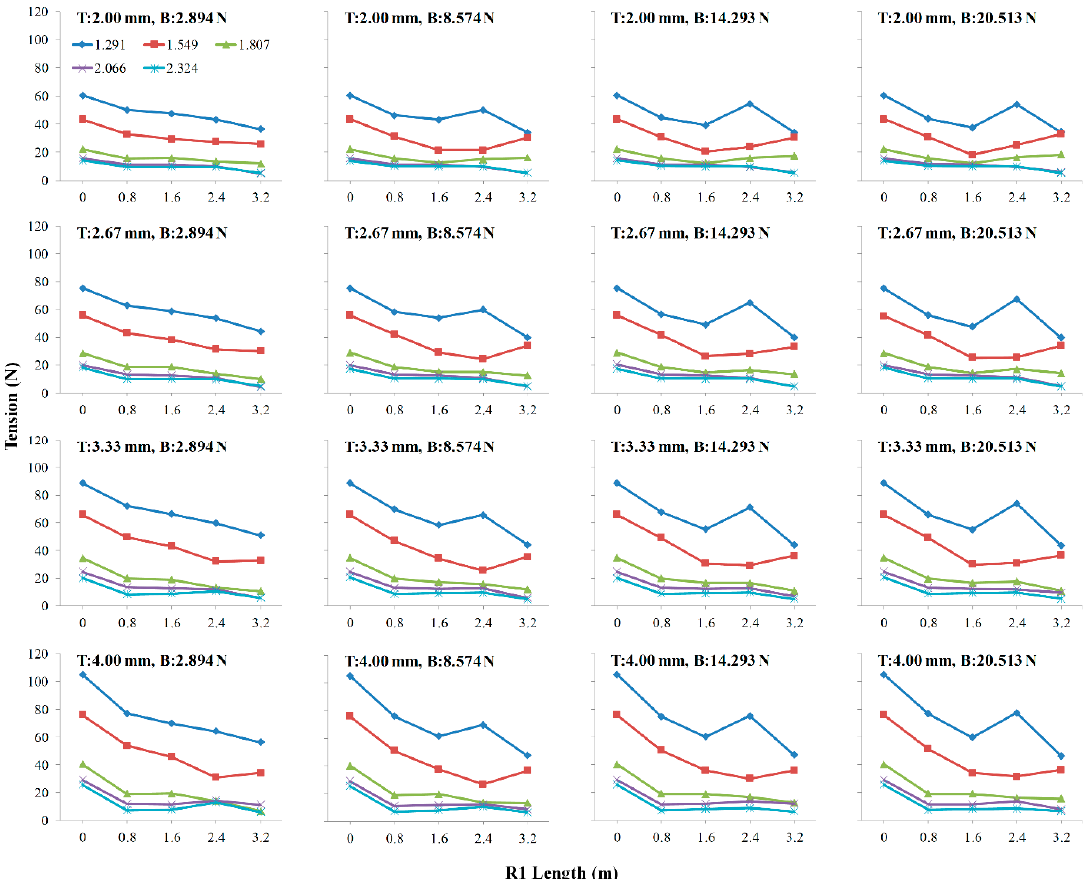
Figure 8. Maximum mooring tension according to the wave period and mooring conditions (rope thickness (T), bridle-line length (R1), and buoyancy of the damping buoy (B)) at a wave height of 0.333 m.